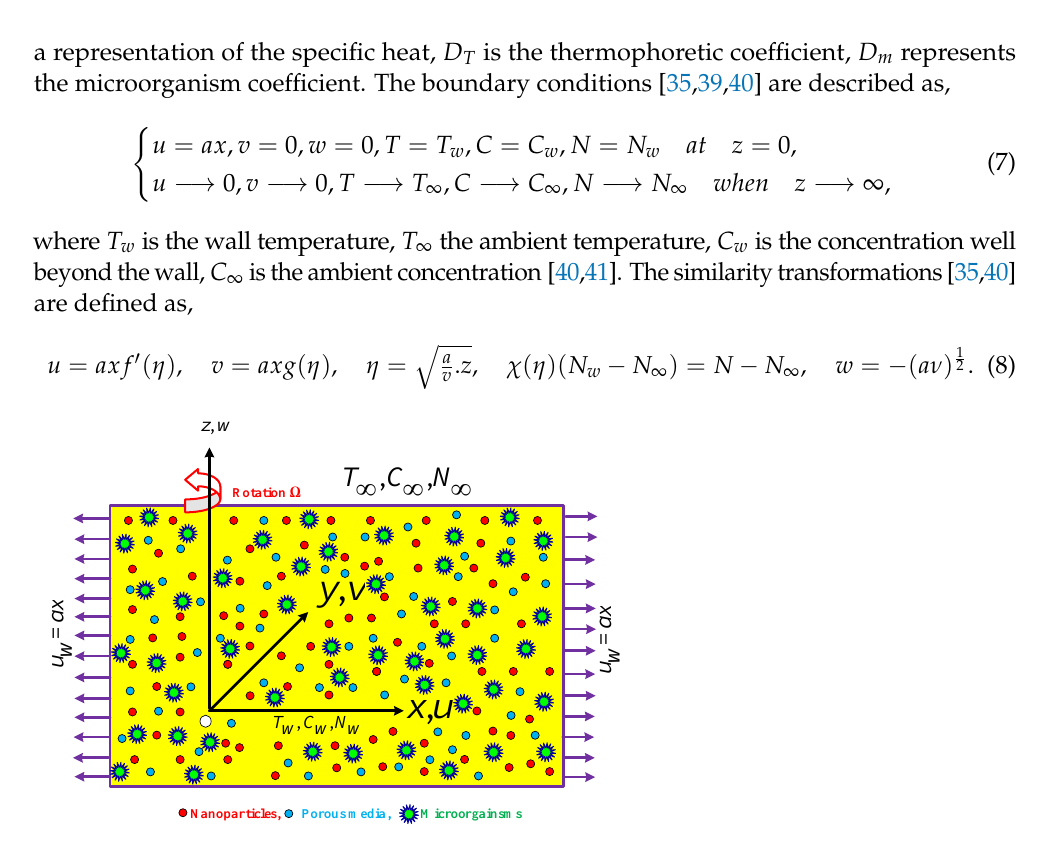
Figure 1. Darcy– Forchheimer flow geometry with bioconvection